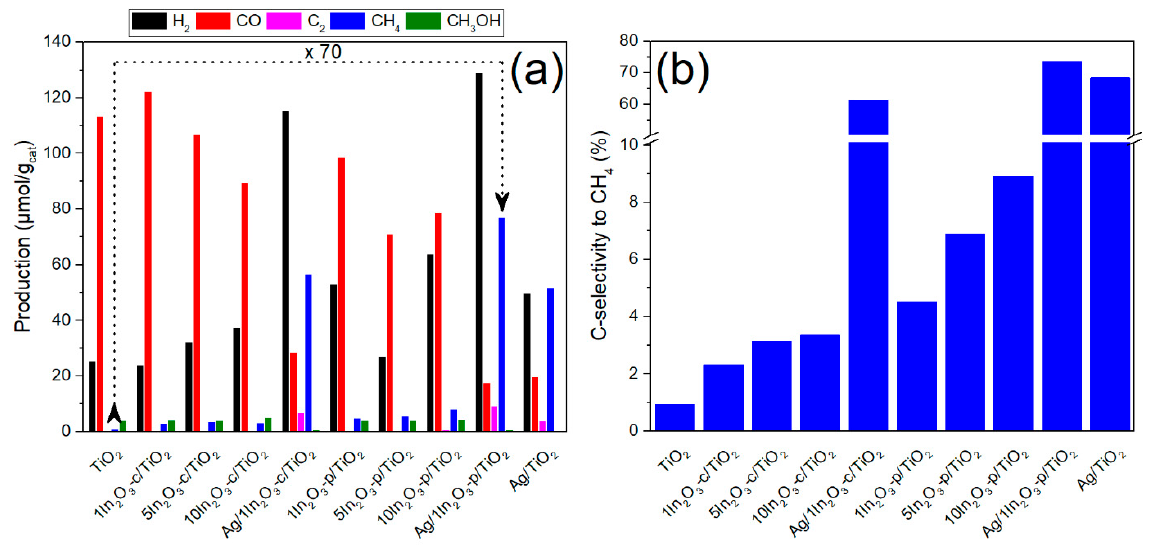
Figure 5. (a) Cumulative production of the main products obtained with different catalysts in the CO 2 + H 2 O reaction after 15 h under UV light. (b) C-selectivities (%) toward CH 4 in the same reaction. CO 2 + H 2 O reaction after 15 h under UV light. ( b ) C-selectivities (%) toward CH 4 in the same